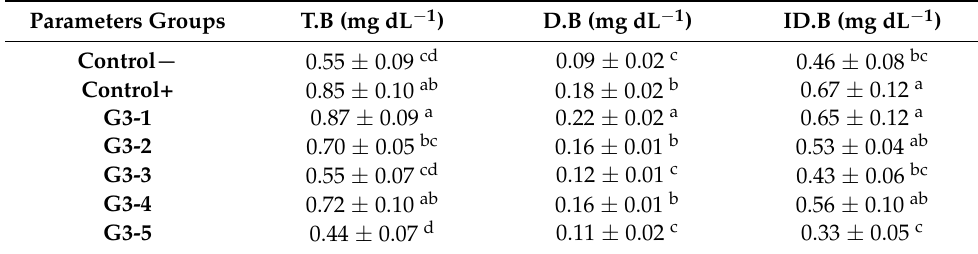
Table 6. Effect of wheat and barley grass on changes in the total bilirubin, direct bilirubin, and indirect bilirubin of rats exposed to toxic metals (mean ±